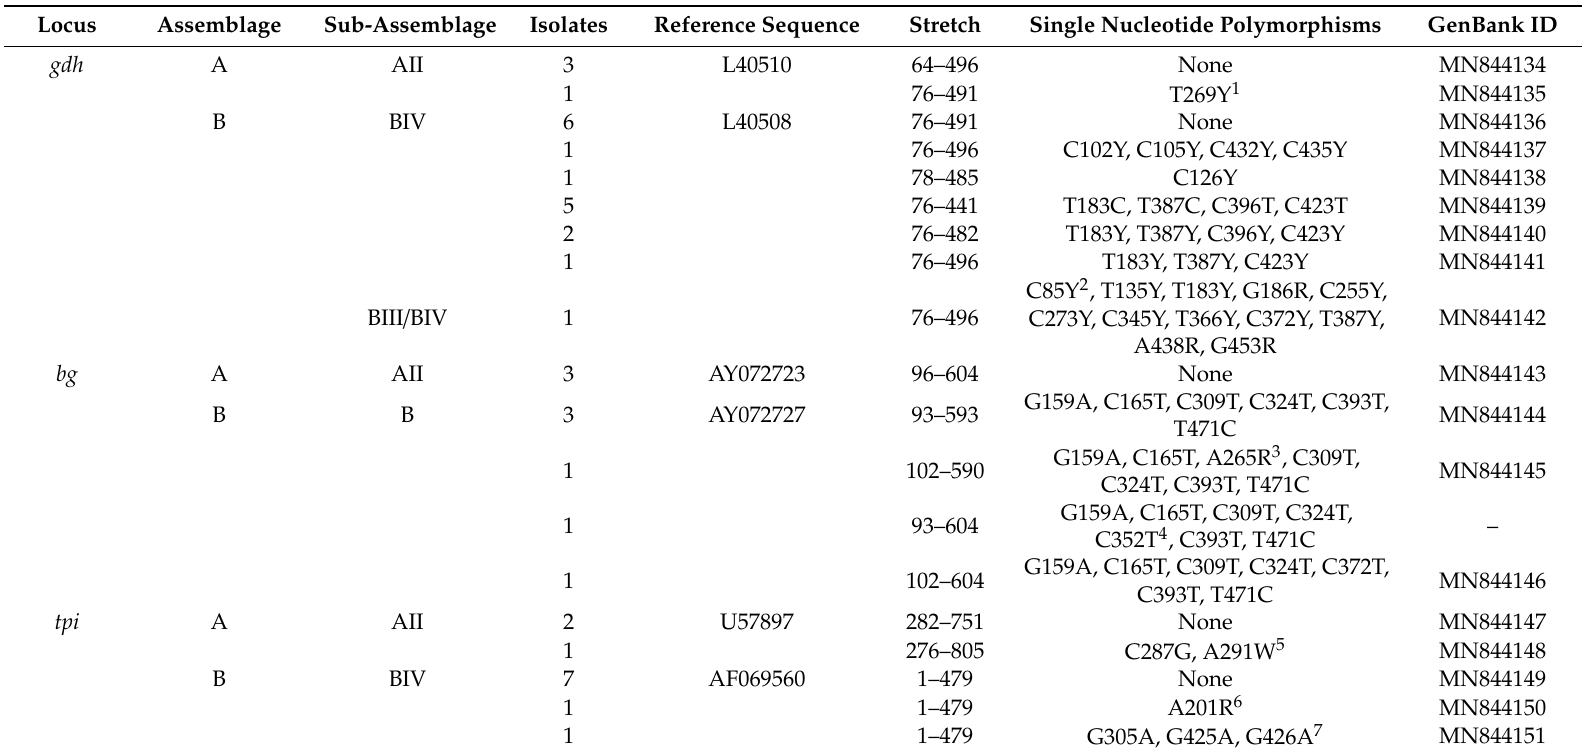
Table 3. Diversity, frequency, and molecular features of Giardia duodenalis sequences at the gdh , bg and tpi loci obtained in the children population under study in Legan é s, Madrid, 2017–2019. GenBank accession numbers are provided. Point mutations inducing amino acid substitutions are highlighted as superscript letters indicating the amino acid